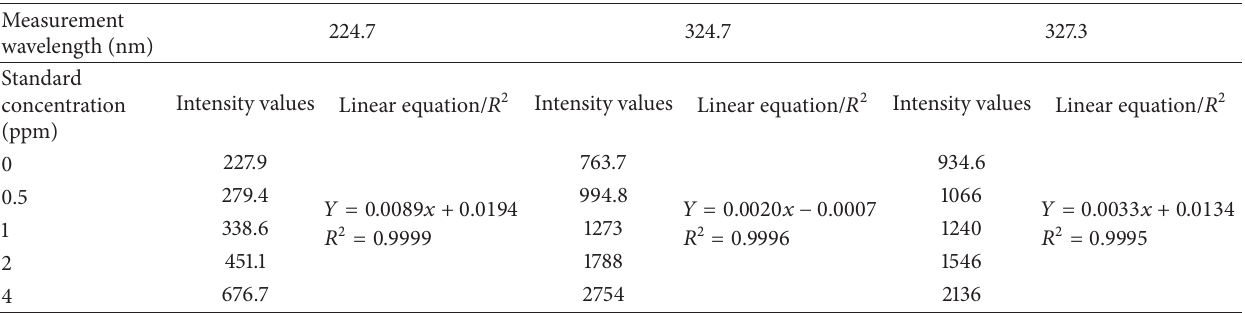
Table 5: Standard concentrations and intensity values under different